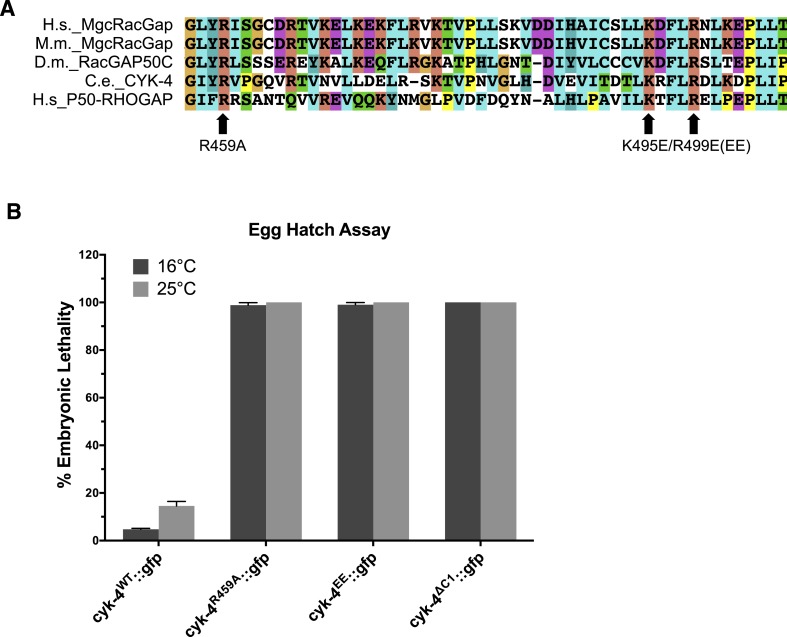
Location and conservation of mutated residues in the CYK-4 GAP domain.(A) Alignment of a region of the GAP domain of CYK-4 from various species and the unrelated RhoGAP P50. The positions of the catalytic arginine (Ce 459) and the conserved basic residues (Ce K495/R499) are indicated. Accession numbers Q9H0H5.1; Q9WVM1.1; AAF58324.1; CAB04593.1; Q07960.1. (B) Embryonic lethality of CYK-4 variants at two temperatures. cyk-4R459A::gfp, cyk-4EE::gfp, and cyk-4∆C1::gfp exhibit fully penetrant embryonic lethality at 16°C and 25°C. cyk-4WT::gfp is included as a control.